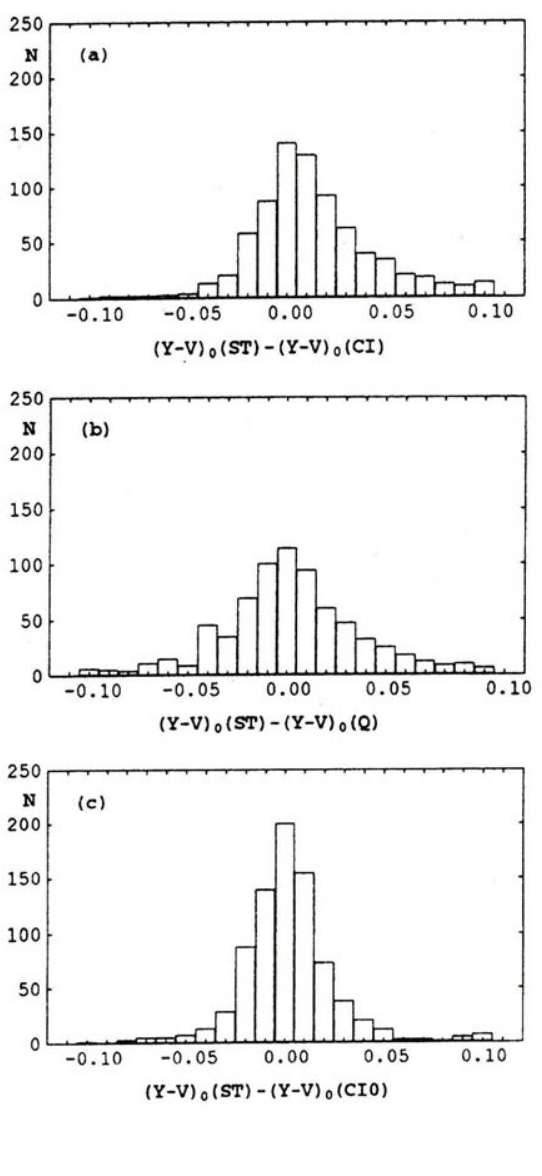
Fig. 2. Distributions of differences between the standard {Y—V)o and the (Y-V)o derived from a comparison of color indices (a), Q parame- ters (b) and intrinsic color indices (c). Only stars with A < 0 .1 mag are presented. Some of the stars have 0.1< A <0.2: 30 in (a), 34 in (b) and 4 in